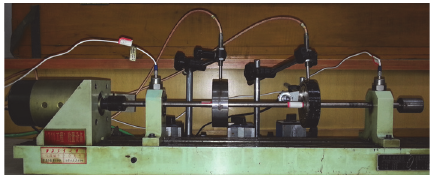
Figure 8: Test rig of the two-disk flexible rotor